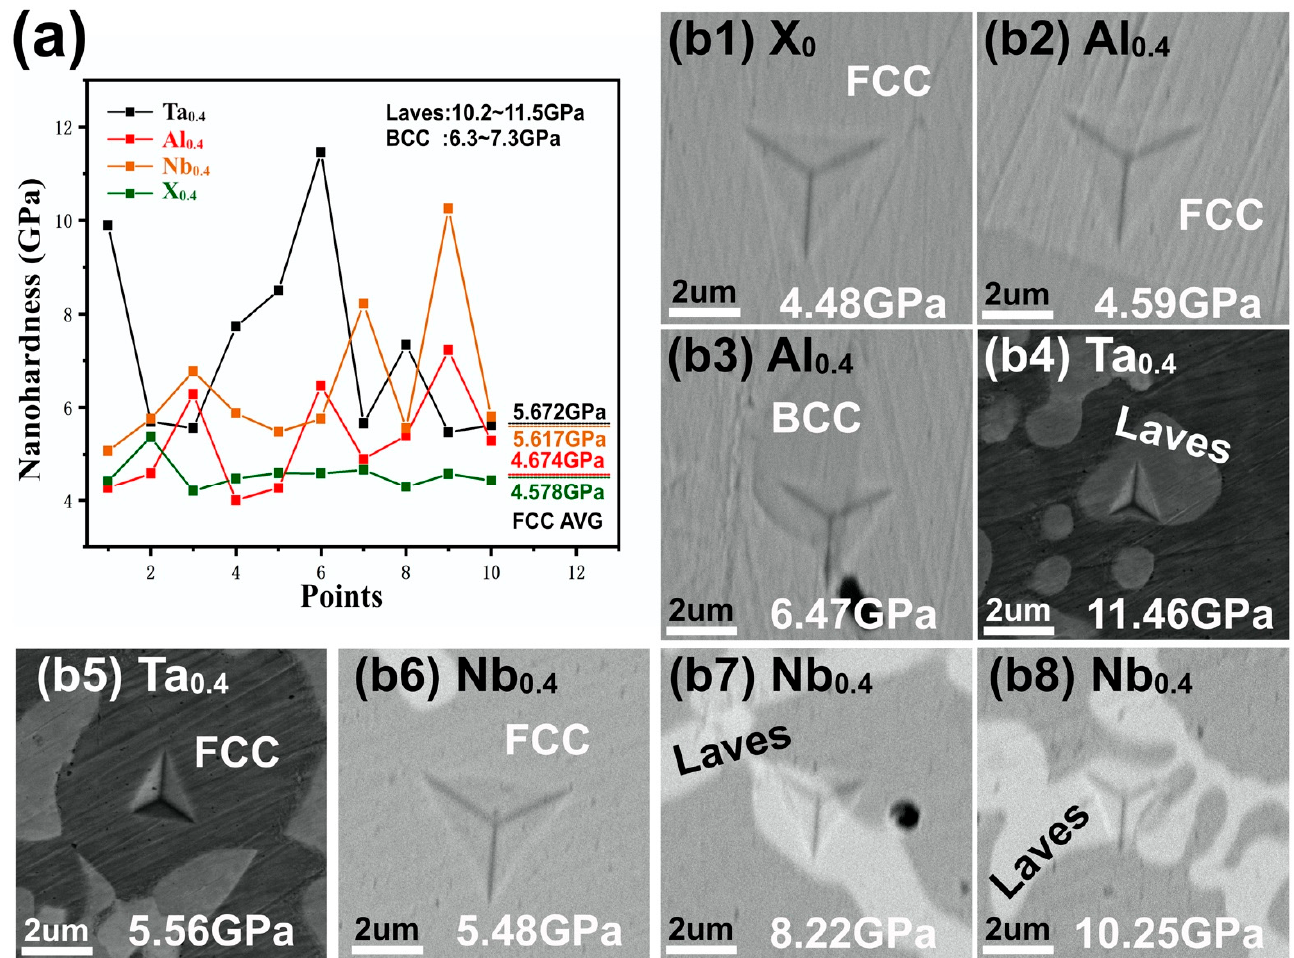
Figure 5. ( a ) The nanohardness distribution and ( b ) nanoindentation morphology of ( b1 ) FCC in CoCrFeNi, ( b2 ) FCC in CoCrFeNiAl 0.4 , ( b3 ) BCC in CoCrFeNiAl 0.4 , ( b4 ) Laves in CoCrFeNiTa 0.4 , ( b5 ) FCC in CoCrFeNiTa 0.4 , ( b6 ) FCC in CoCrFeNiNb 0.4 , ( b7 ) and ( b8 ) Laves in CoCrFeNiNb 0.4 .